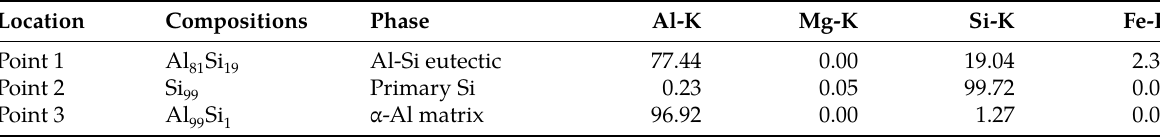
Table 3: EDS analysis of as-cast alloy of Al-28Si